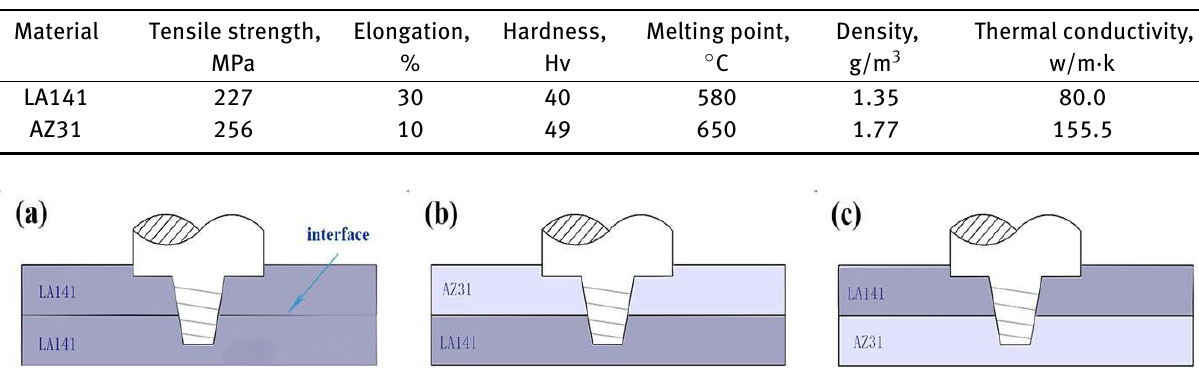
Table 2: Mechanical properties of LA141 Mg-Li alloy and AZ31 Mg alloy.